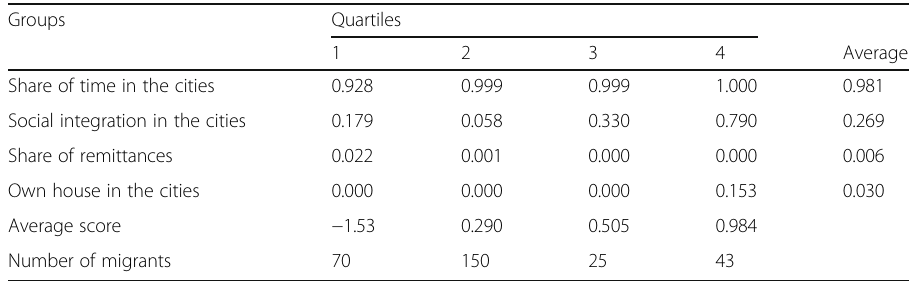
Table 4 Index of Migration Intensity Groups